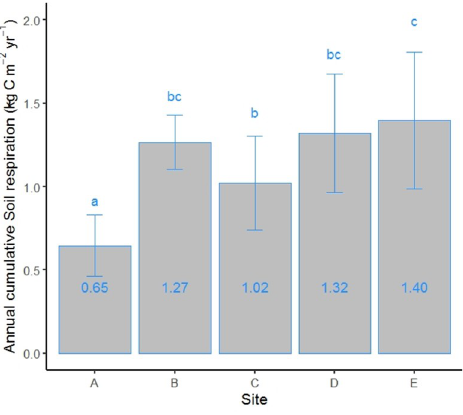
Fig 4. Total cumulative soil respiration (kg C m -2 yr -1 ) for the different sites. Error bars indicate standard deviation. Different letters indicate significant differences between